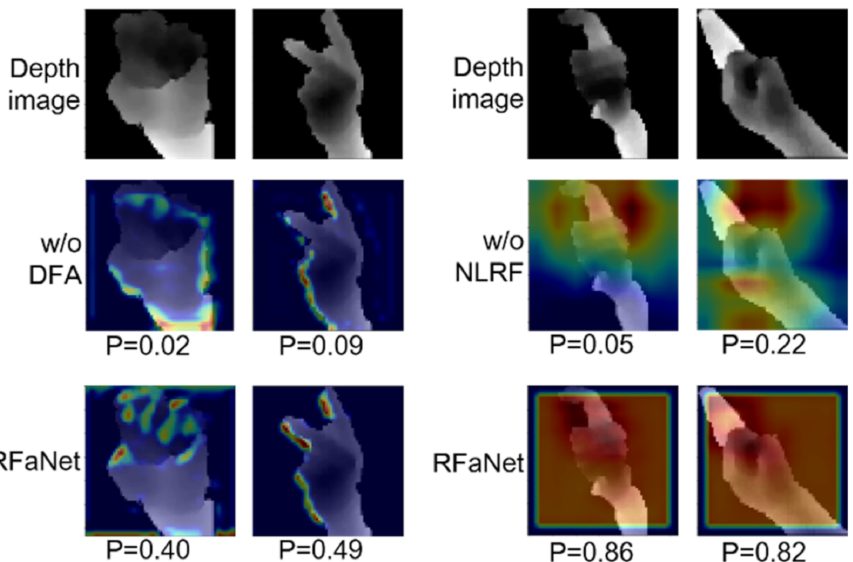
Figure 7. Grad-CAM visualization of the effects of the DFA and NLRF blocks on the ASL dataset. The left two columns show the feature maps of the first bottleneck layer of RFaNet to analyze the effect of the DFA block. The right two columns show the feature maps of the last bottleneck layer of RFaNet to analyze the effect of the NLRF block. w/o: without; P: softmax score of the ground-truth